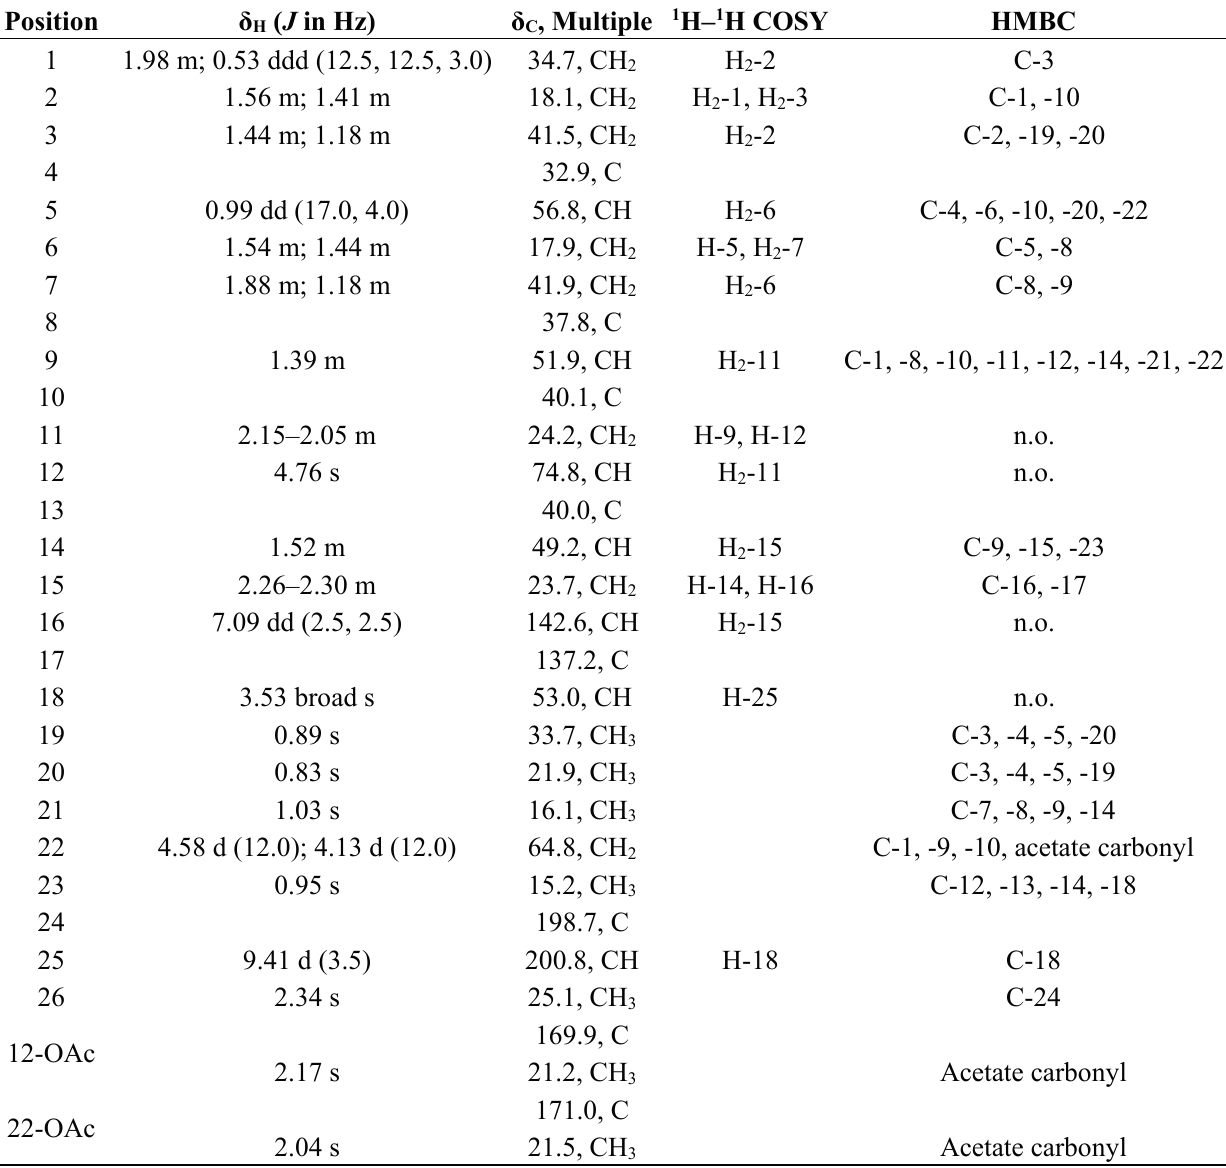
Table 2. 1 H (500 MHz, CDCl 3 ) and 13 C (125 MHz, CDCl 3 ) NMR data and 1 H– 1 H COSY and HMBC correlations for homoscalarane 2